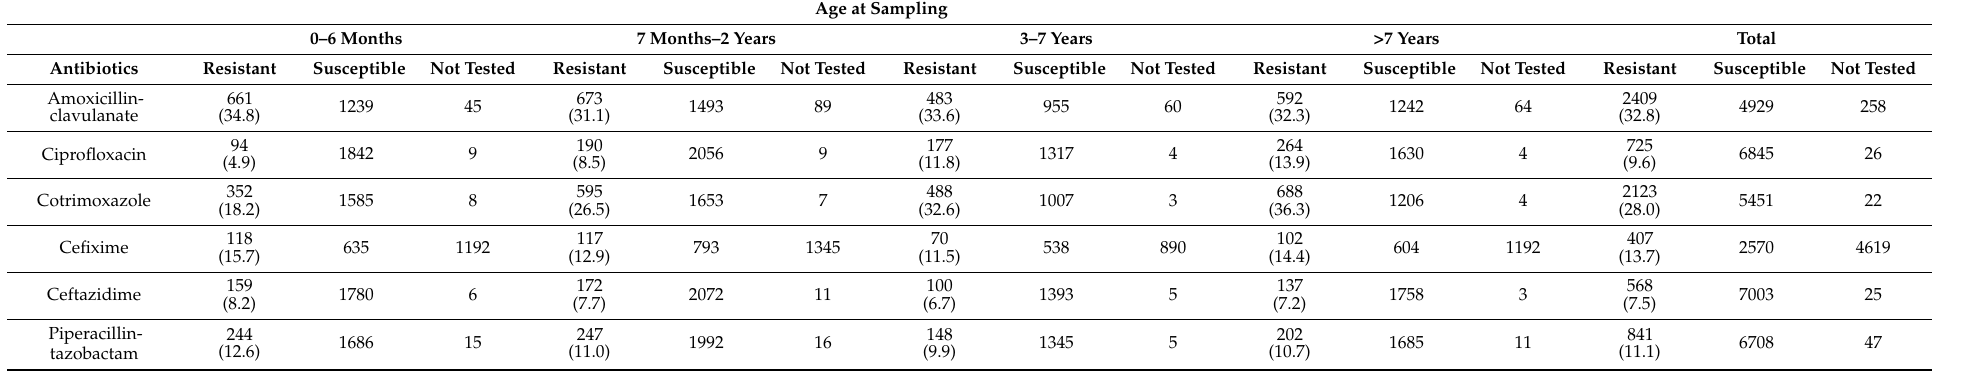
Table 1. Distribution antibiotic resistance among 4902 Escherichia coli and 2694 other Enterobacteriales by age at sampling.